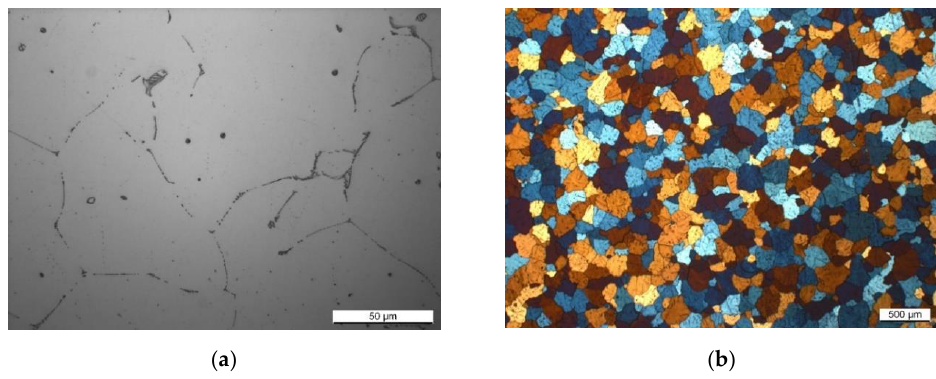
Figure 2. Initial microstructure of cast and homogenized AA 1050: ( a ) etched in Nital (2 vol.%); ( b ) micrograph taken in polarized light.